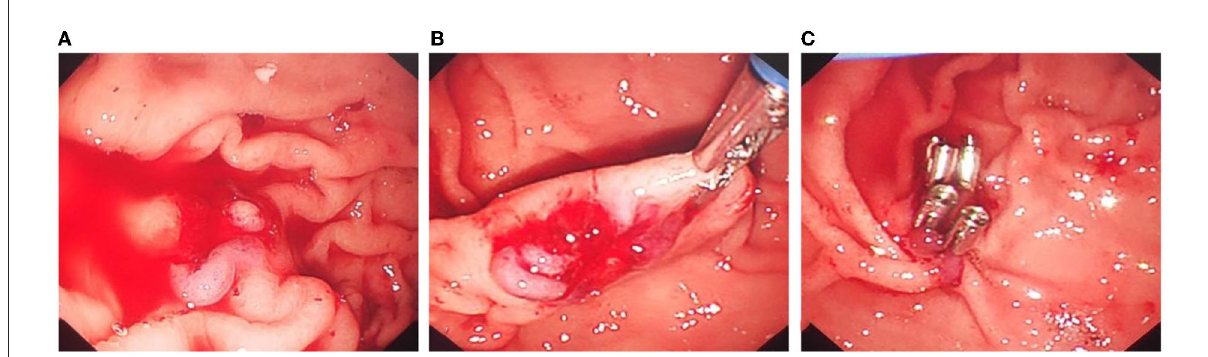
FIGURE4 Titanium clip closure of abnormal blood vessels in the Dieulafoy’s disease under gastroscopy. (A) After cleaning the old bleeding in the gastric cavity, continuous bleeding of exposed malformed blood vessels can be seen. (B) There was no obvious abnormality in the mucosa around the lesion, and the exposed artery was bleeding quickly. (C) Titanium clips were used to clip the exposed abnormal blood vessels to stop bleeding.